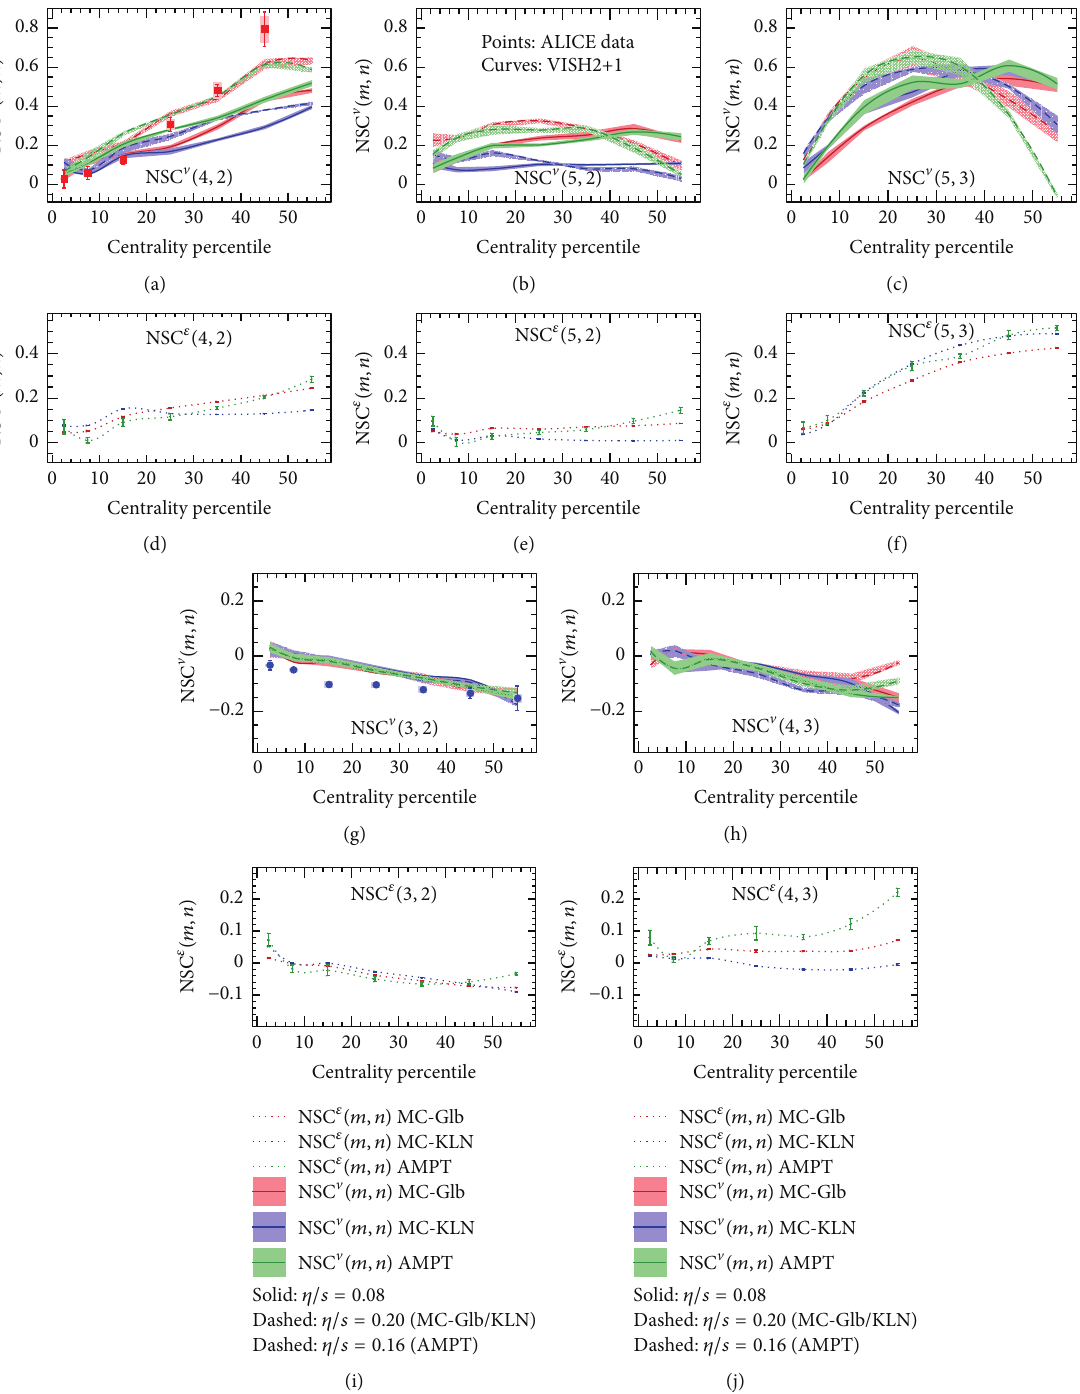
Figure 8: The centrality dependence of normalized symmetric cumulants NSC (𝑚,𝑛) at √𝑠 NN = 2.76 TeV Pb–Pb collisions by VISH2+1 simulations. Figures are taken from